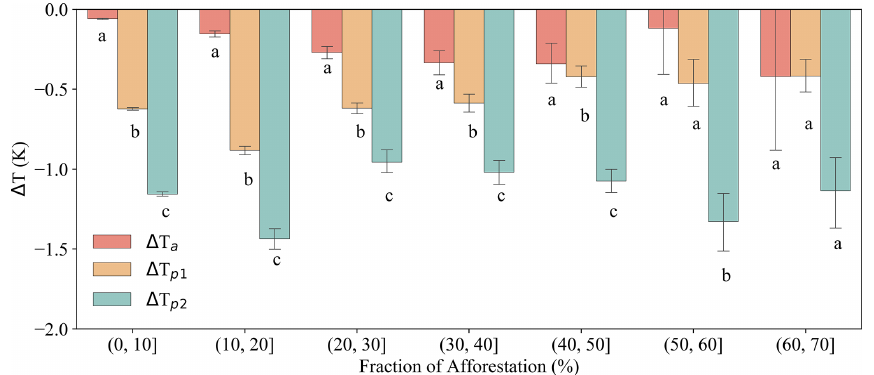
Figure 6. Comparison of (cid:49)T for the three approaches for bins of afforestation intensity. Error bars are given as the standard error, and different letters indicate that (cid:49)T calculated by the two approaches concerned are significantly different using the adjusted p value after applying the Bonferroni correction for multiple paired-sample t tests.